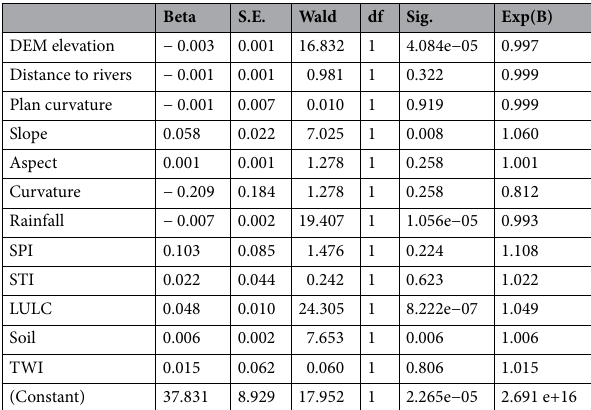
Table 5. Parameter of